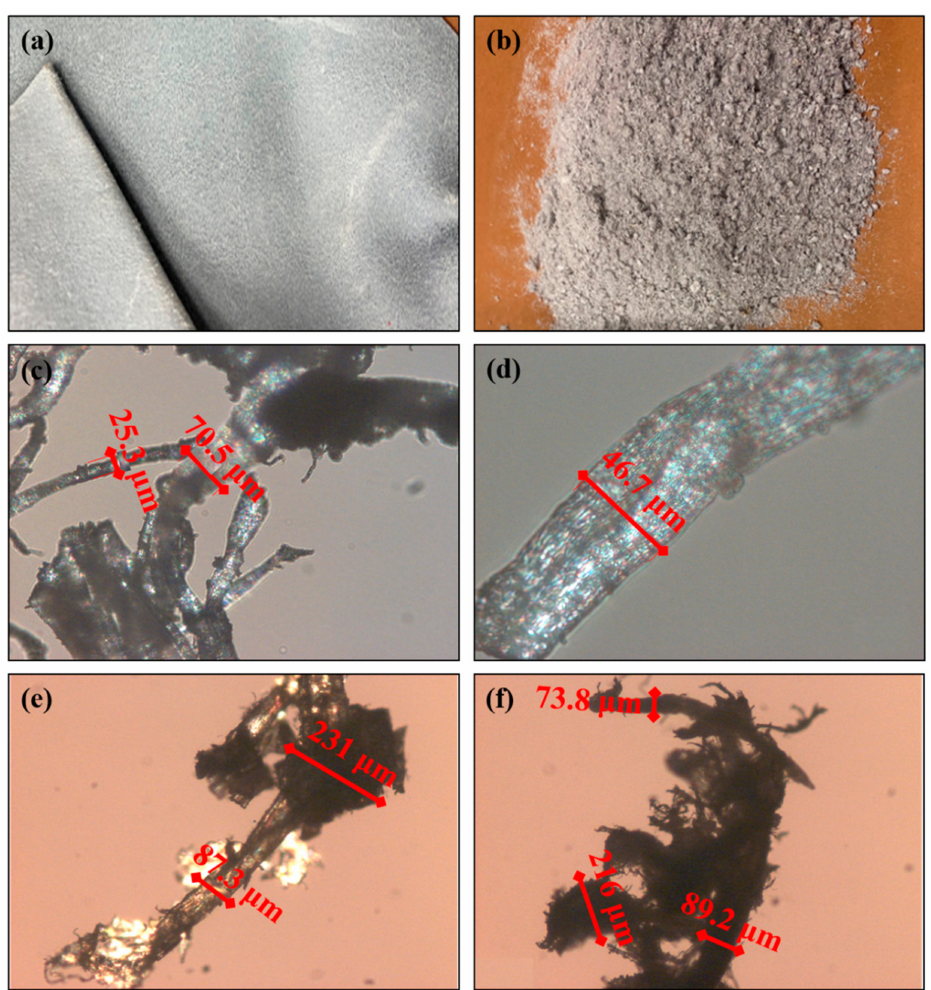
Figure 1. Pictures of the WB leather before ( a ) and after ( b ) grinding and images of the grinded WB fibers taken by an optic microscope ( c – f ). It is possible to recognize three different structures: the main fibrous body (mean diameter of 70 µ m), branched and exfoliated tiny fibers (22 µ m), and bulky and coarse entangled fiber clusters (222 µ